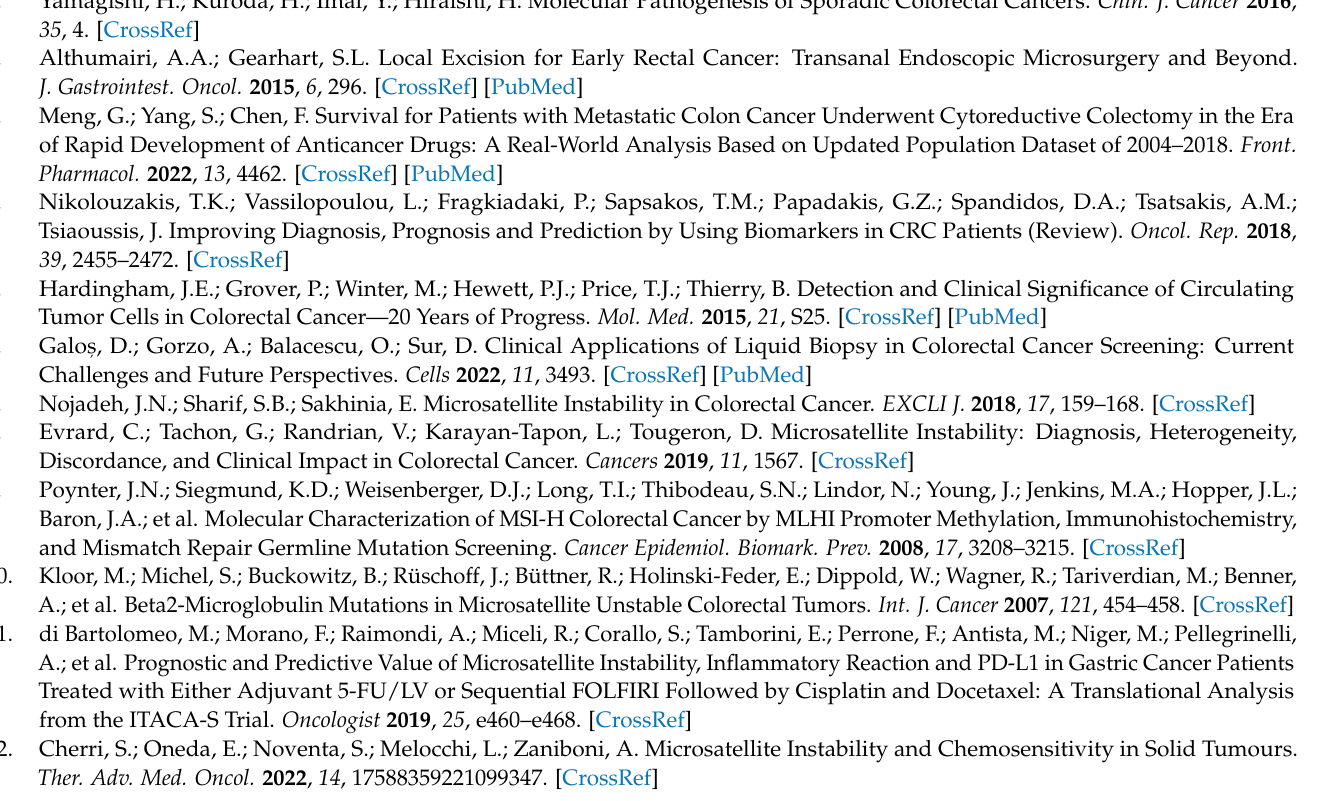
Table S8: GO analysis on CNA genes in the wild-type CRC group; Table S9: Clinical-pathological features of TMA CRC